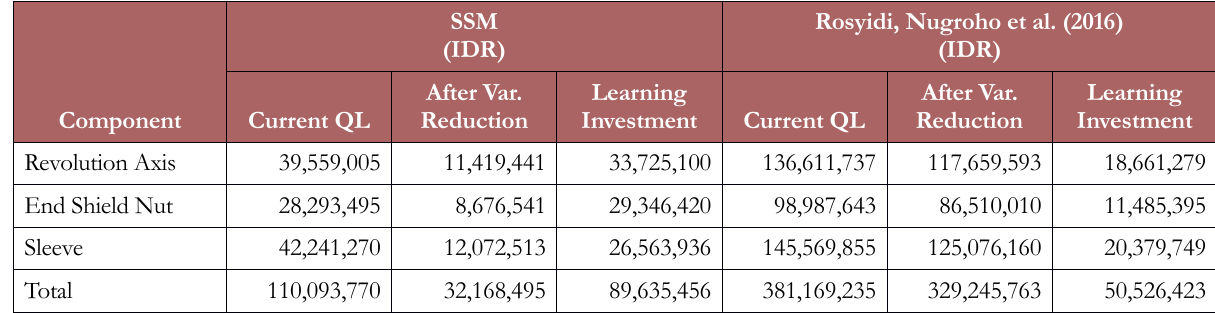
Table 23. Results of model comparison